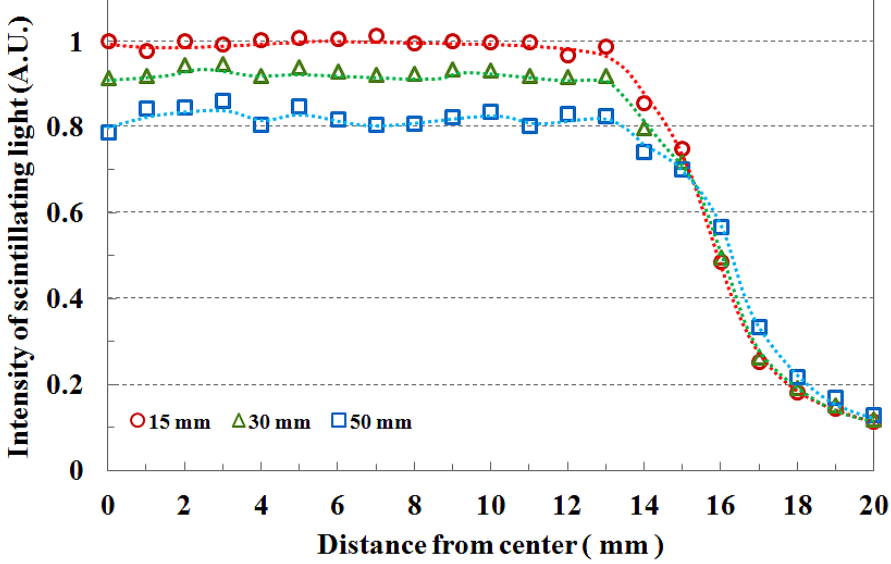
Figure 5. Transverse dose distribution of 3 × 3 cm 2 field size according to the depth.